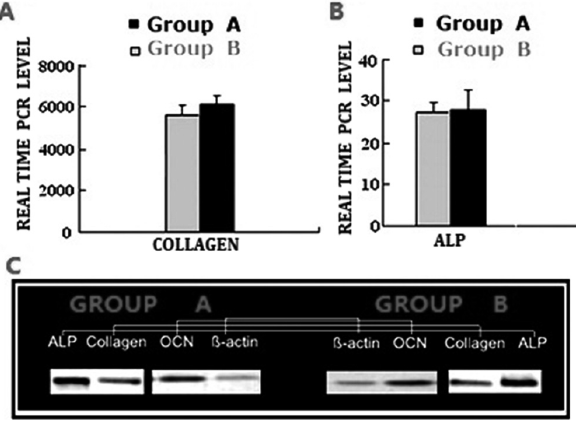
Fig. 4. Real-time quantitative PCR and RT-PCR